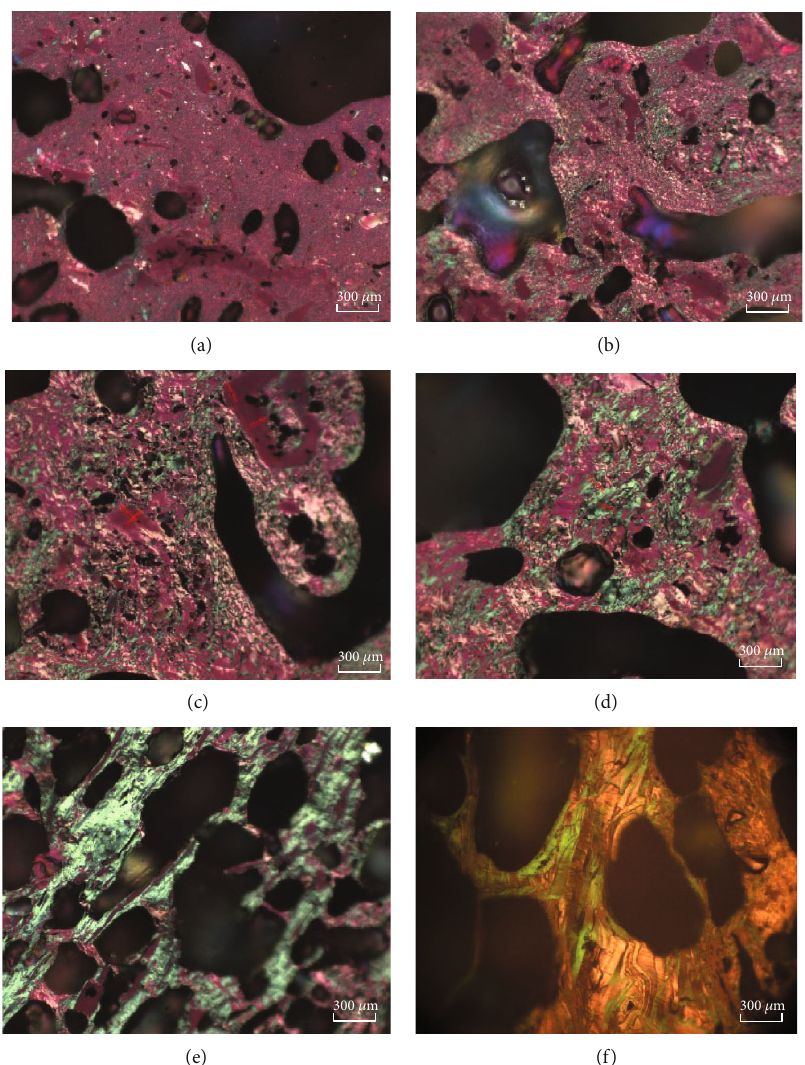
Figure 2: Several common COT images: (a) fi ne-grained mosaic tissue; (b) medium-grained mosaic tissue; (c) coarse-grained mosaic tissue; (d) coarse-grained incomplete fi ber tissue; (e) complete fi ber tissue; (f) fl ake